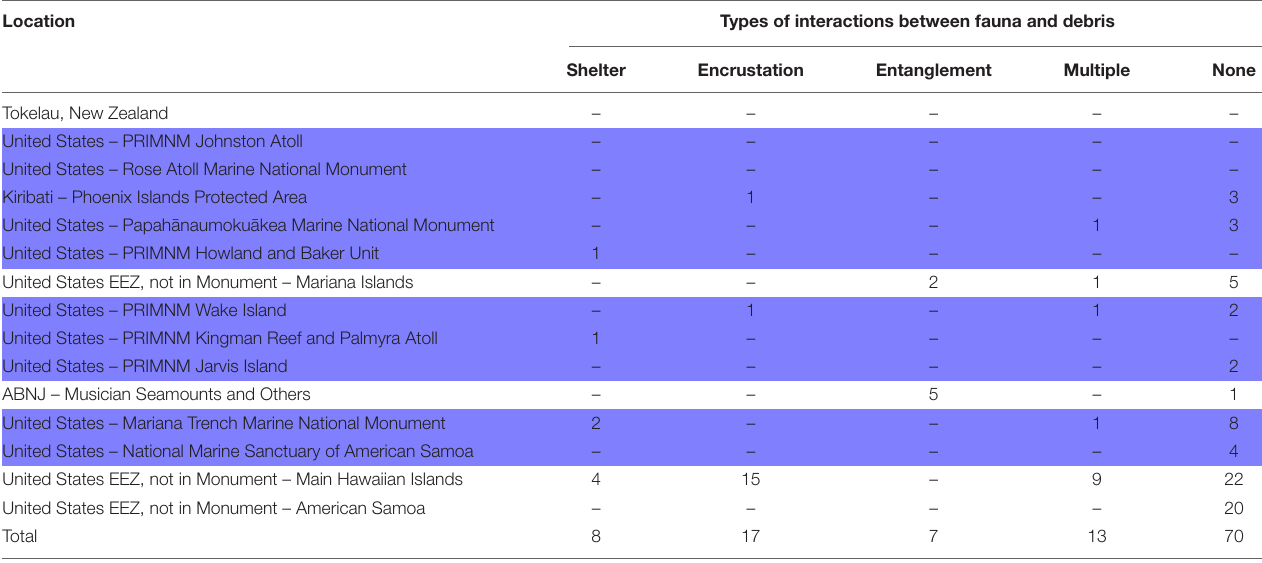
FIGURE 5 | Deep-sea debris density by distance from human settlement (km). In an attempt to standardize sampling effort, each distance category contained 21 deep-sea ROV dives except for the last category, which had 20 dives. TABLE 2 | Interactions of fauna with deep-sea debris in the central and western Pacific.